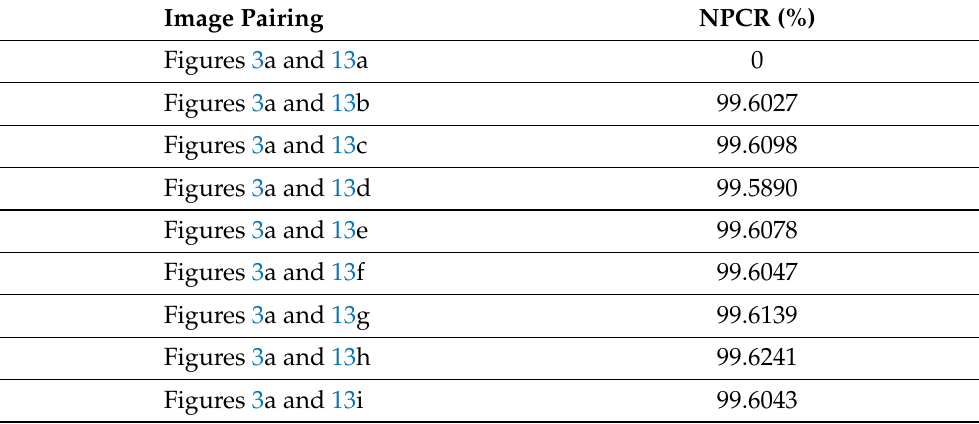
Table 7. NPCR values for the original image OImg01 and the results illustrated in Figure 13.